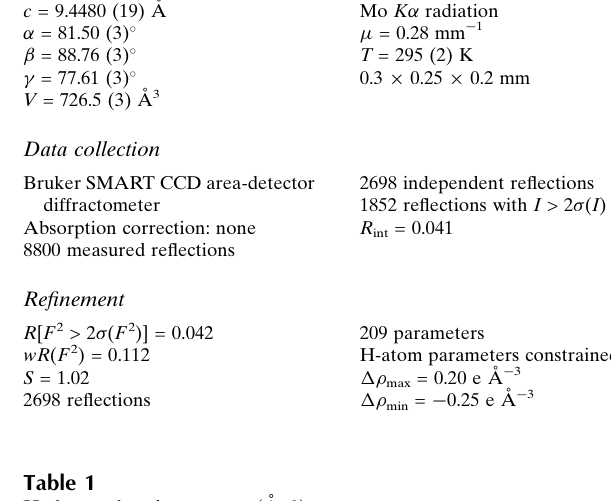
Hydrogen-bond geometry (A˚ , (cid:3)